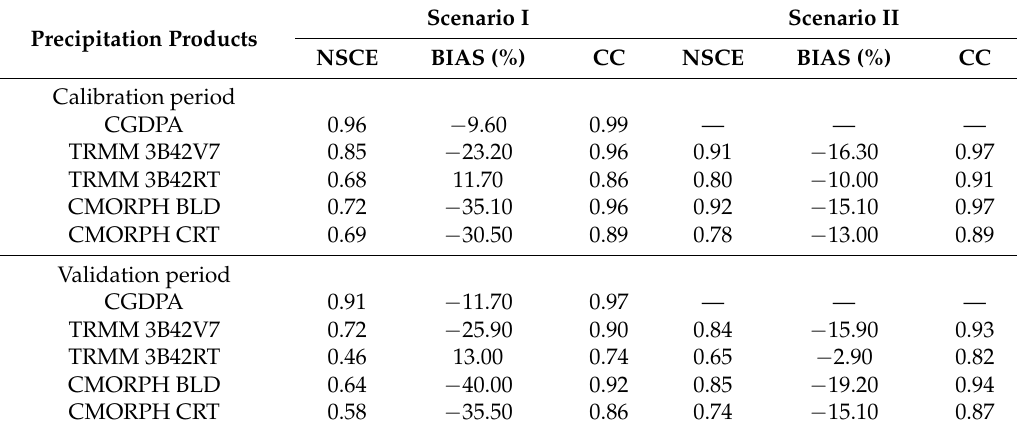
Table 5. As in Table 4, but for monthly